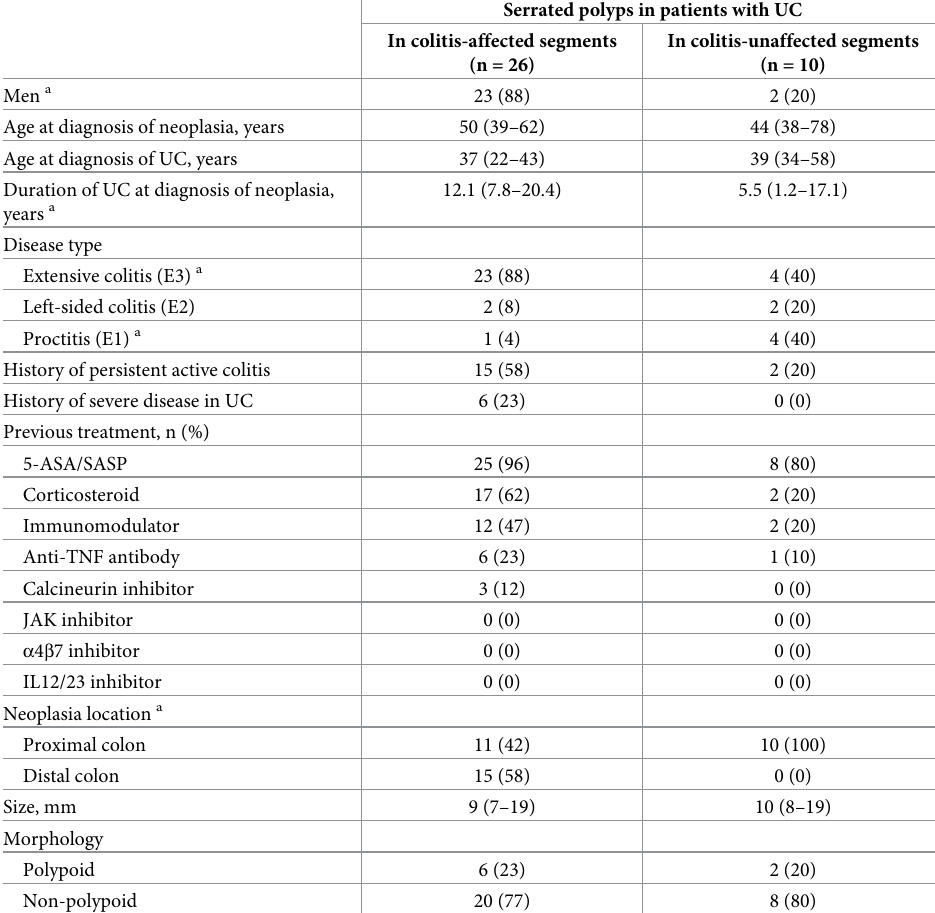
Table 2. Clinical characteristics of serrated polyps in patients with